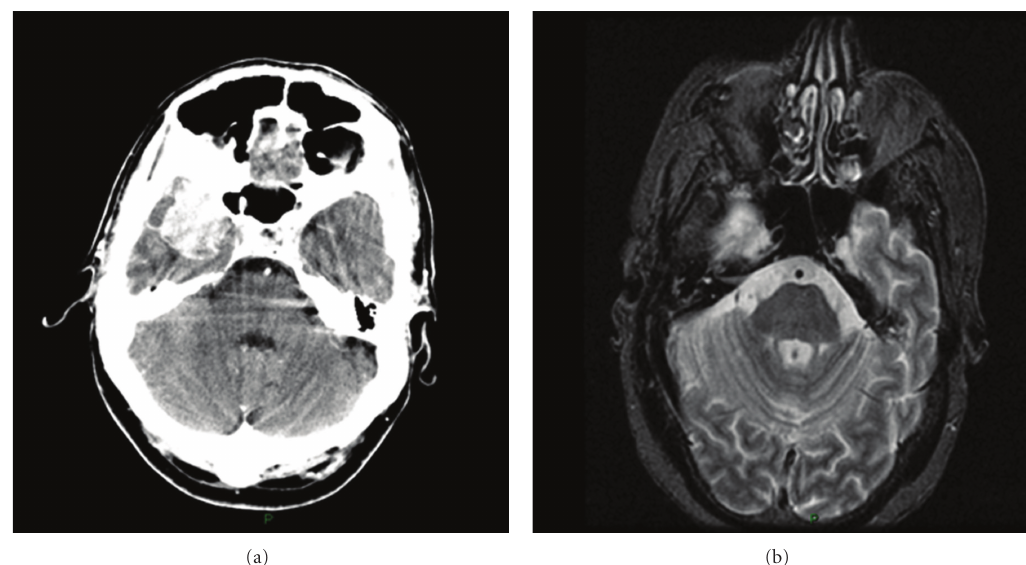
Figure 1: CT scan (a) and MRI (b) revealed a 4.5 × 4.5 × 3-cm mass that enhanced with contrast, in the right greater wing of the sphenoid bone which was invading the anterior pole of the temporal lobe and the sphenoid sinus.